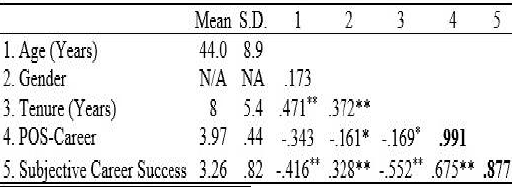
Table 3: Correlation Matrix of Variables